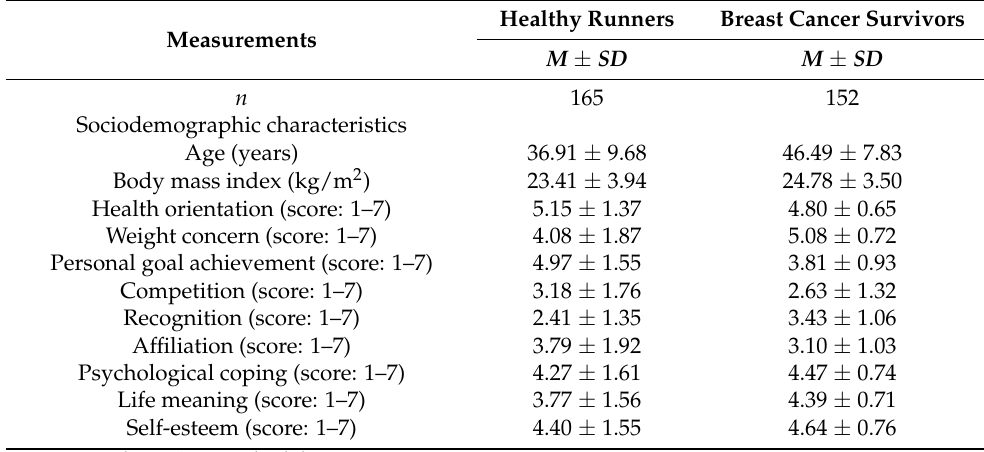
Table 1. Descriptive statistics of the sample of the study for healthy runners and BC survivors. Healthy Runners Breast Cancer Survivors Measurements 165 Sociodemographic